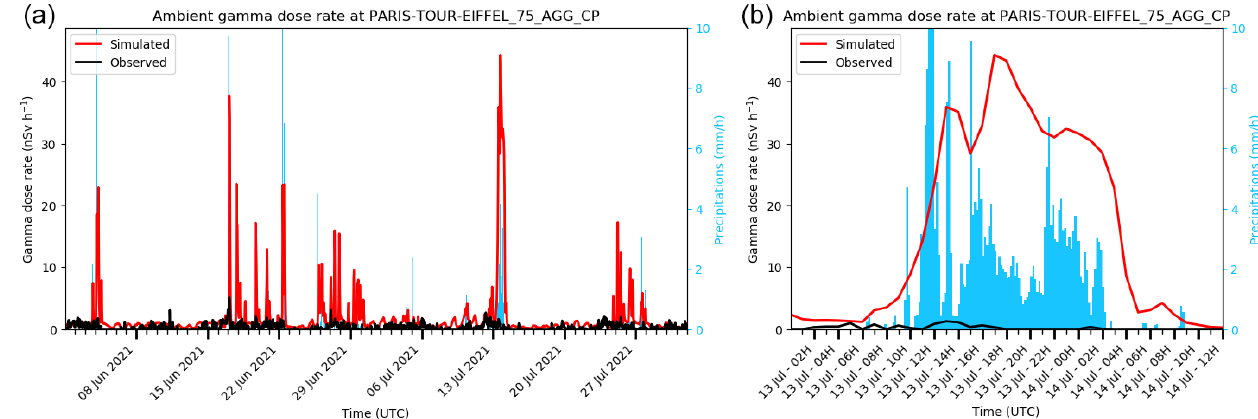
Figure 9. Observed and simulated ambient gamma dose rates at the Paris Tour Eiffel station. (a) In June and July 2021. (b) The 13 July